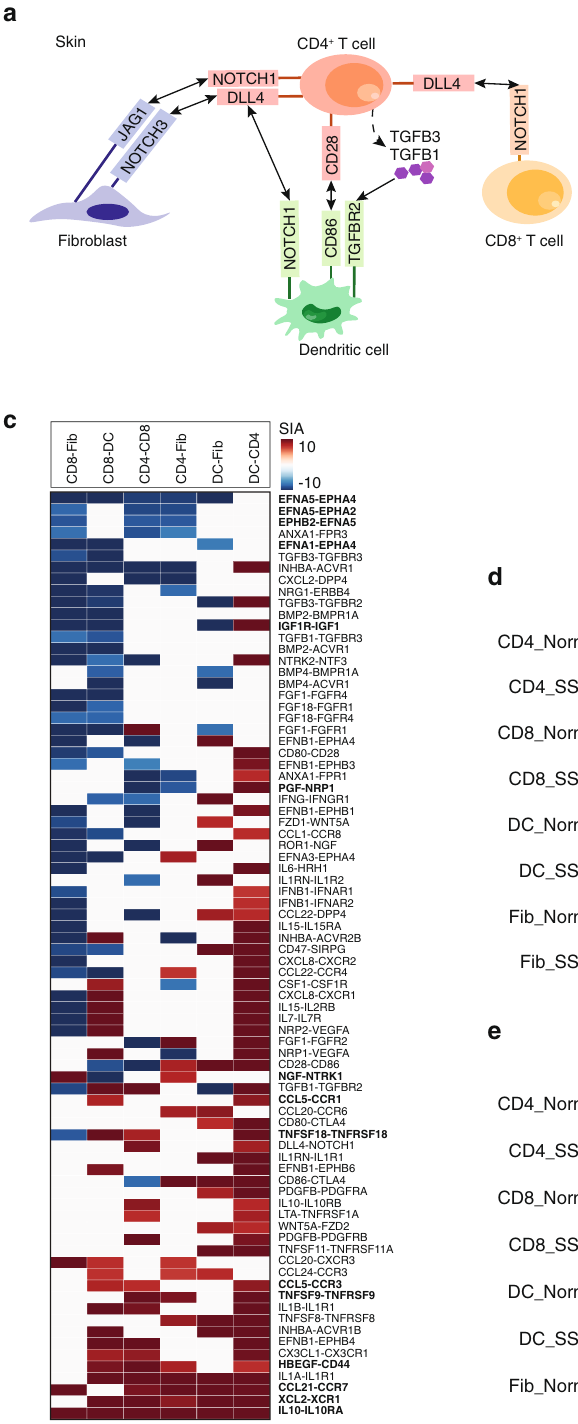
Row-sum of up-regulated Row-sum of down-regulated